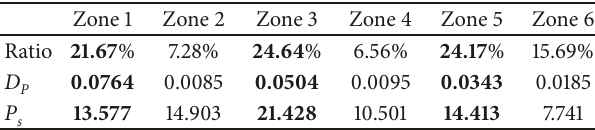
Table 5: Parameters in different